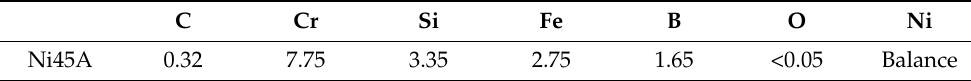
Figure 1. Statistical analysis of powder morphology and particle size: ( a1 , a2 ) B 4 C; ( b1 , b2 ) Nb; ( c1 , c2 ) Ni45. Table 1. Chemical composition of Ni45